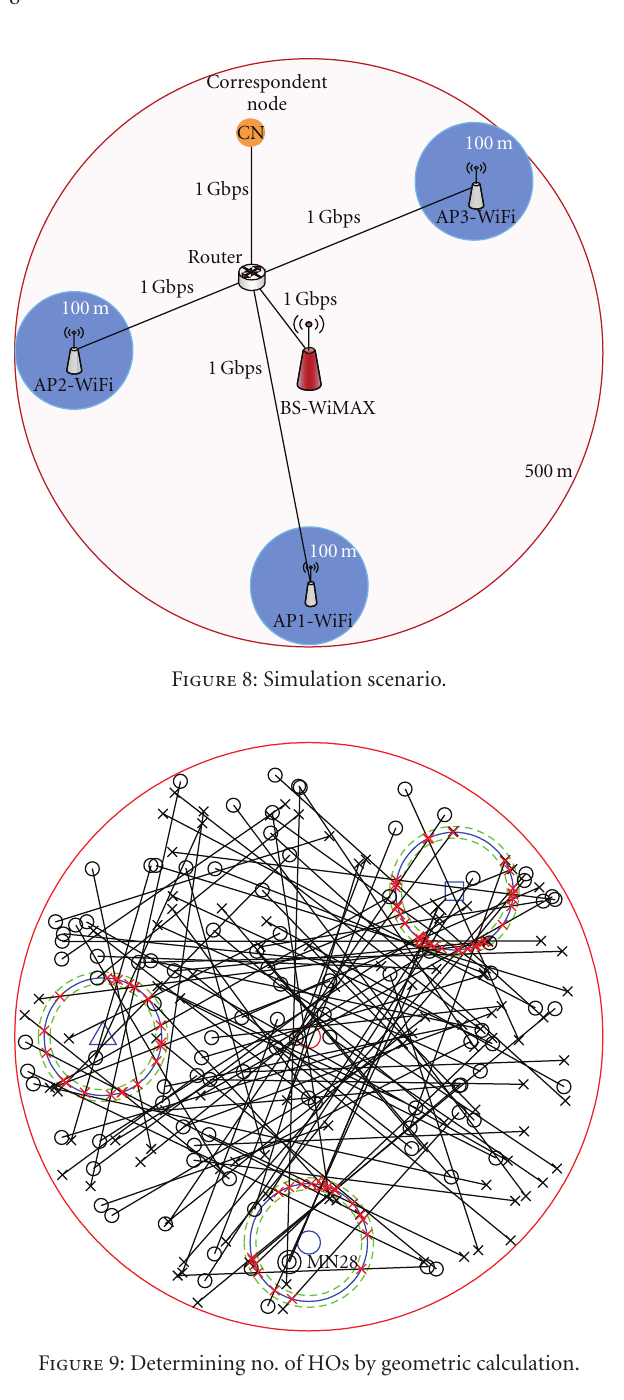
The trajectories for 100 MNs triggering a total of 79 han- dovers can be seen in Figure 9; the big circle corresponds to the WiMAX coverage area, the three small circles correspond to the three Wi-Fi cells coverage and the lines correspond to MN trajectories. Each line starts with a small circle (MN start position) and ends with a cross (MN end position). The intersections between lines and the three Wi-Fi circles are indicated by small triangles. Each Wi-Fi cell has also two doted circles representing the power boundaries described in Section 3.2.6.